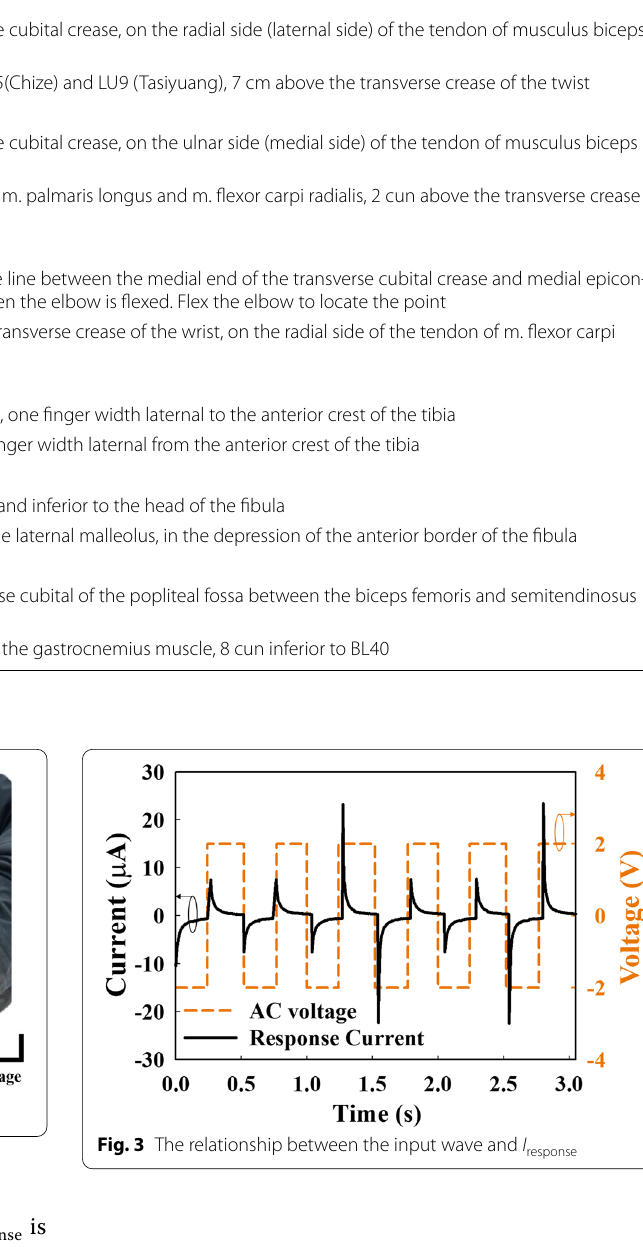
Table 1 Selected acupoints with detailed locations Acupoints Location